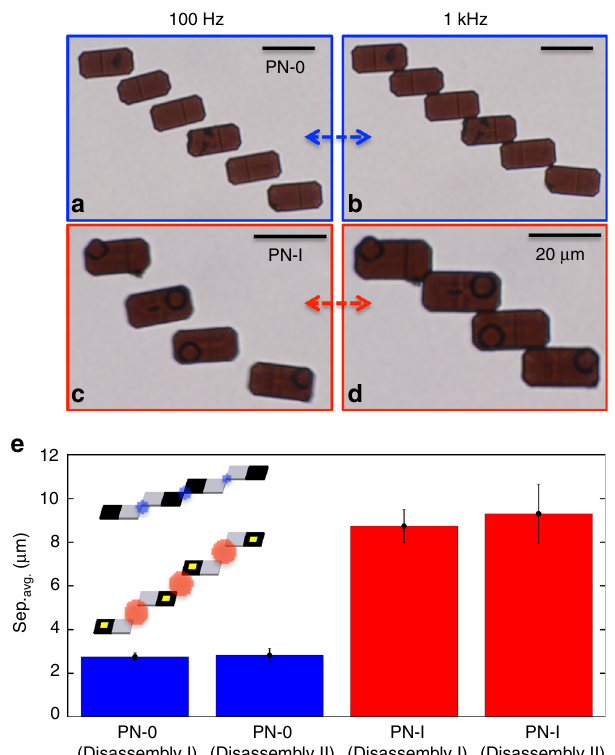
Fig. 4 Electrically switchable assembly and disassembly of PN-0 and PN-I microparticles. a – d Interaction of six PN-0 ( a , b ) and four PN-I ( c , d ) microparticles (scale bar = 20 μ m) at frequencies of 100 Hz (left) and 1 kHz (right) at fi xed fi eld strengths of E 2 = 40 kV 2 cm − 2 . e Average separation distance between microparticles. The blue bars correspond to the average distance between PN-0 microparticles 1.0 s after disassembly (at t 1 = 6.0 and t 2 = 12.0 s). The red bars correspond to the average distance between PN-I microparticles 1.0 s after disassembly ( t 1 = 6.0 and t 2 = 12.0 s). The error bars represent SD (one above and one below for the error bars) for measurements between multiple disassembly events in a single